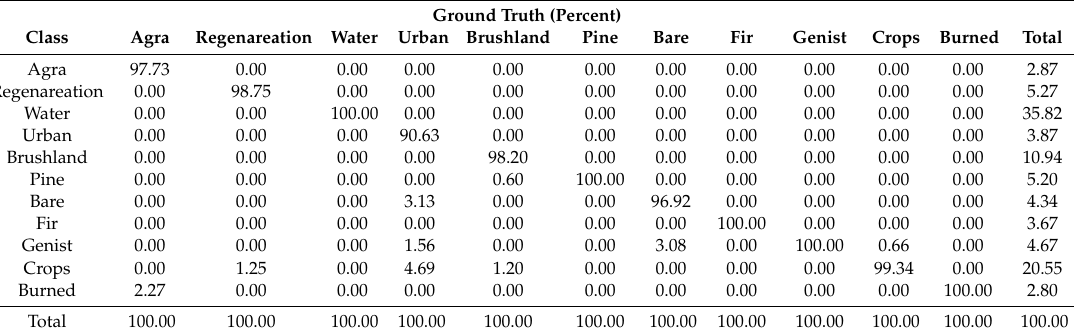
Figure 6. Land cover changes: ( a ) 1993-2001, ( b ) 2001–2010 and ( c ) 1993–2011. Table 5. Confusion matrix for the year